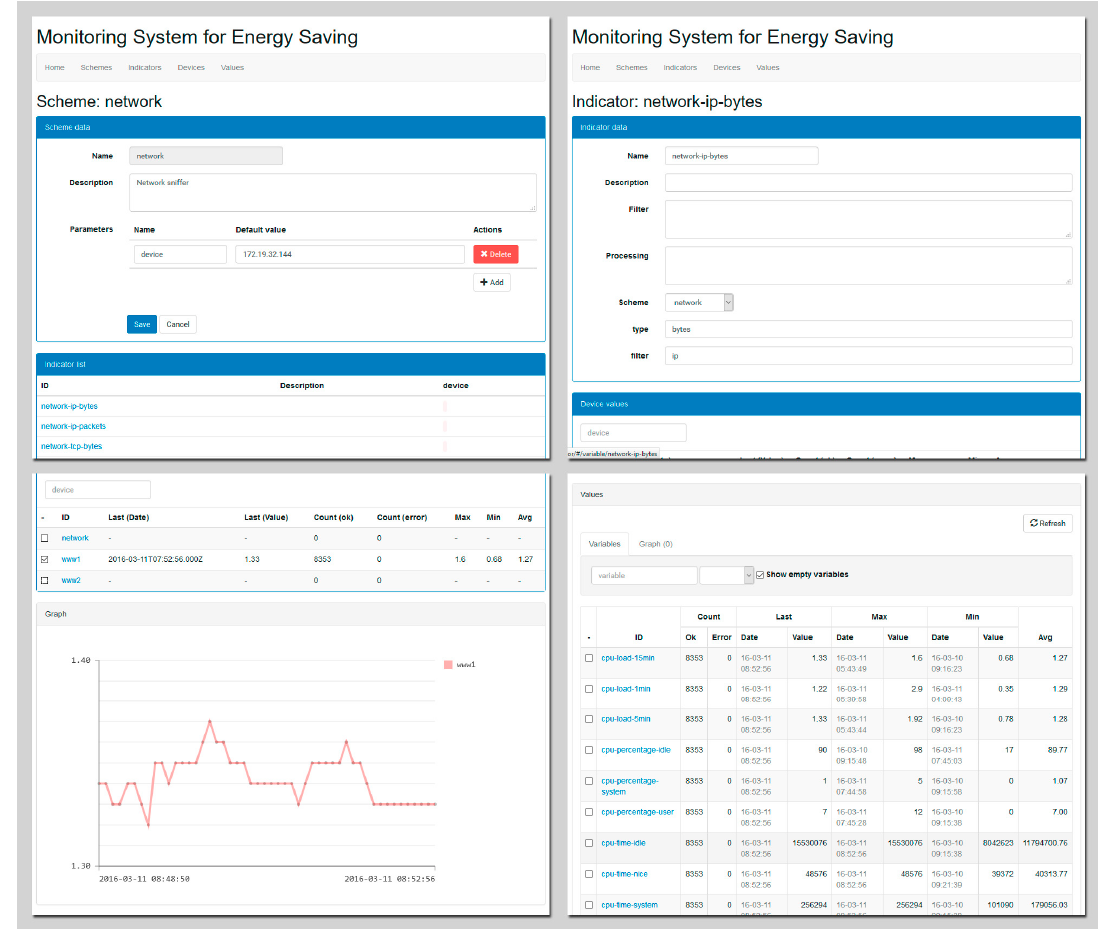
Figure 13. Monitoring system (MS) for energy saving